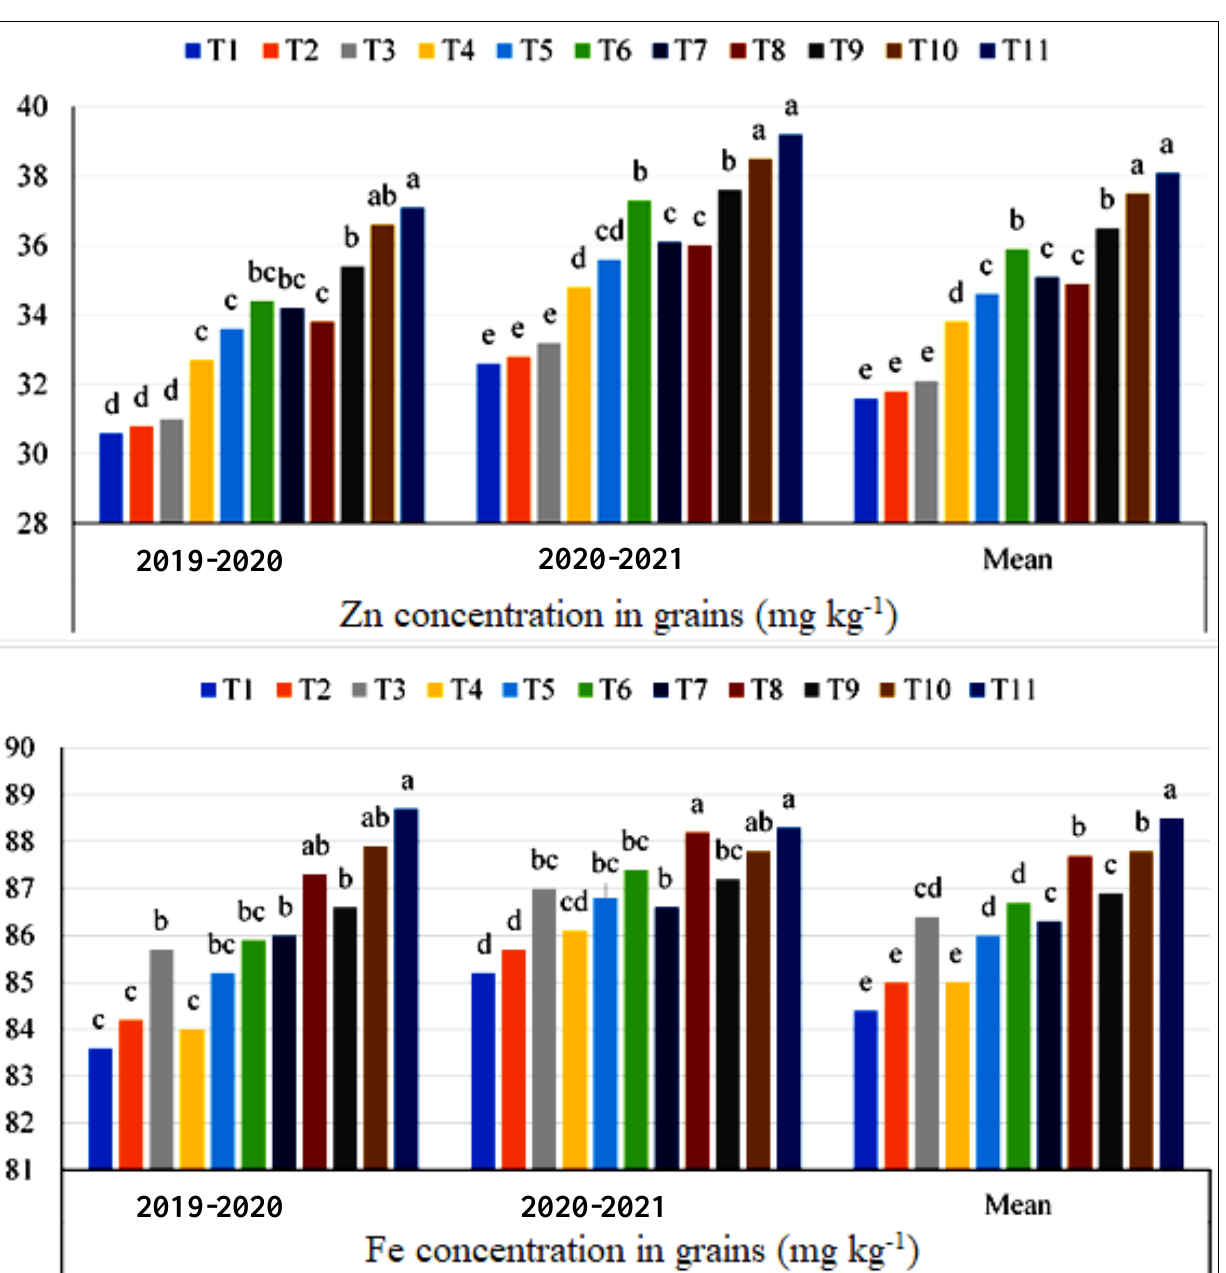
Figure 3. Effect of micronutrient and urea spray-on Zn and Fe concentration (mg kg − 1 ) in grains of Indian mustard. Treatments details are available in Table 1. The bar with a similar or dissimilar letter(s) was evaluated with the least significant difference (LSD) multiple range tests using a probability level of p ≤ 0.05.